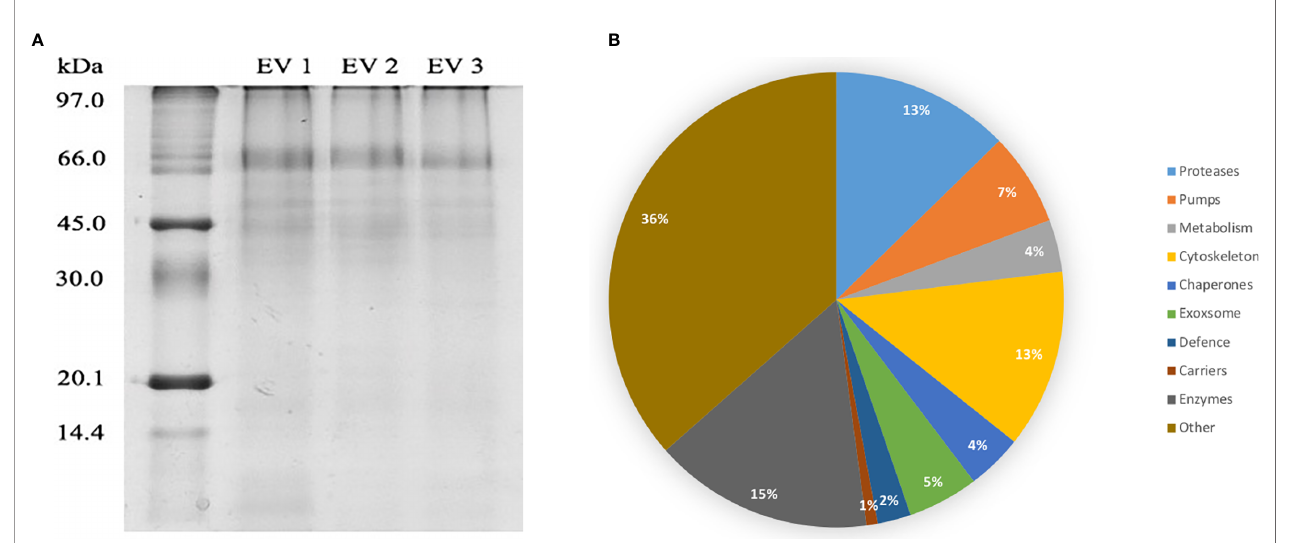
FIGURE 2 | (A) EV proteome arrays of lysed C. daubneyi EVs (n=3). EVs released in vitro were lysed and subjected to 12.5% 1D polyacrylamide gel analysis and colloidal Coomassie blue stained. All biological replicates produced a highly reproducible pro fi le. (B) Categorization of all sequences returned from the C. daubneyi EV proteome. Proteins consistent across three replicates were submitted to Interpro and GeneOntology searches and assigned to 9 functional categories as de fi ned by Cwiklinski et al. (2015). Proteins that did not fi t any of the nine categories were placed into a fi nal category classi fi ed as ‘ other ’ . Cytoskeleton associated proteins accounted for 13% of the sequences resolved, Proteases 14%, Enzymes 8%, Chaperones 7%, Transporters 4%, Exosome biogenesis 3%, Metabolism 5%, Carriers 1% with Others fi lling the remaining